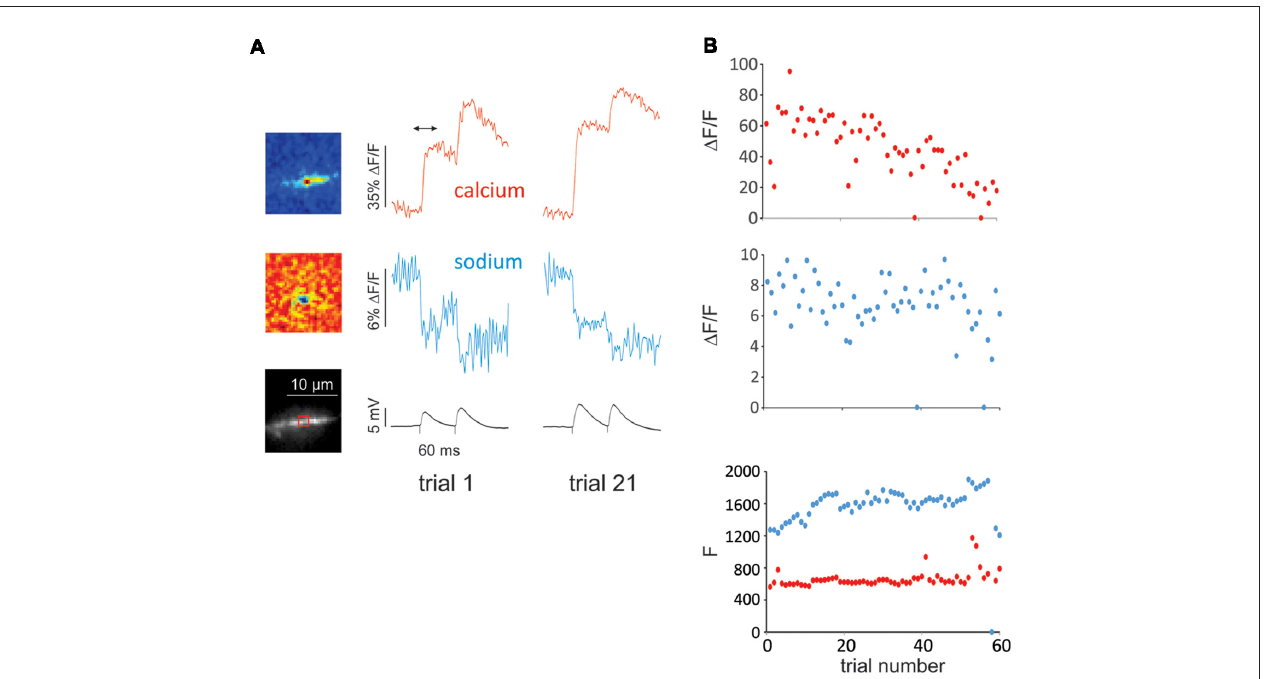
FIGURE 4 | Example of experiment with many trials showing little cumulative photodynamic damage reflected in single spine sodium and calcium signals. (A) Pseudocolor difference images (top) and image of dendritic region with ROI indicated (bottom). The difference images show the spatial distribution of the calcium and sodium signals from the first of two synaptic stimuli (time marked by arrow above calcium signal) of the first of 60 trials. The cells were filled with 50 µ M OGB-1 and 2 mM SBFI from a patch pipette on the soma. The pseudocolor images show that both changes were localized to a small region corresponding to a dendritic spine. The traces show that the signals from trial 1 and trial 21 were about the same. (B) Plots of peak signal sizes ( ∆ F/F) from the first synaptic response and resting fluorescence levels (F) for all 60 trials. The F values were measured at the beginning of the traces before stimulation. The peak calcium signal ( ∆ F/F, red dots) decreased slightly over the many trials; the peak sodium signal ( ∆ F/F, blue dots) showed little deterioration. In two trials (38 and 55) there was failure in both the sodium and calcium signals (an unusually small number). The F values stayed relatively constant until the last few trials. In four trials the resting calcium F levels were high, probably because the trials were preceded by spontaneous synaptic responses. The resting sodium F value did not change significantly.